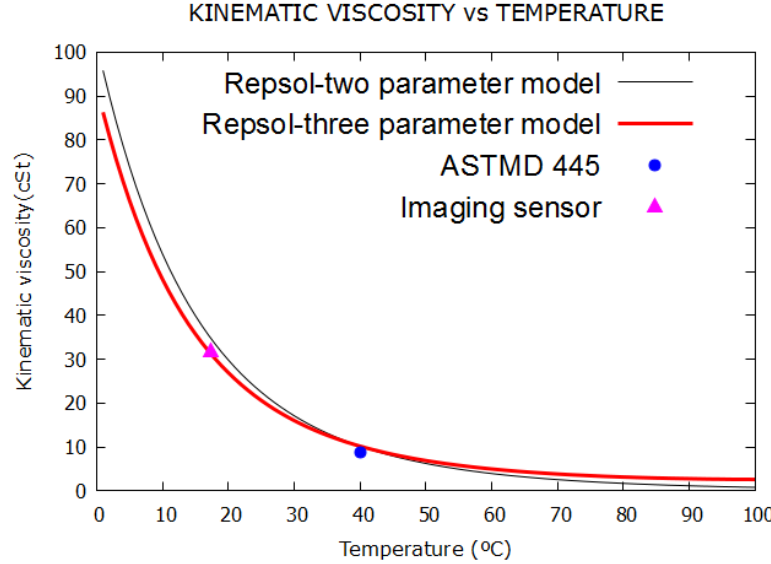
Figure 24. Kinematic viscosity versus temperature in dielectric oil.